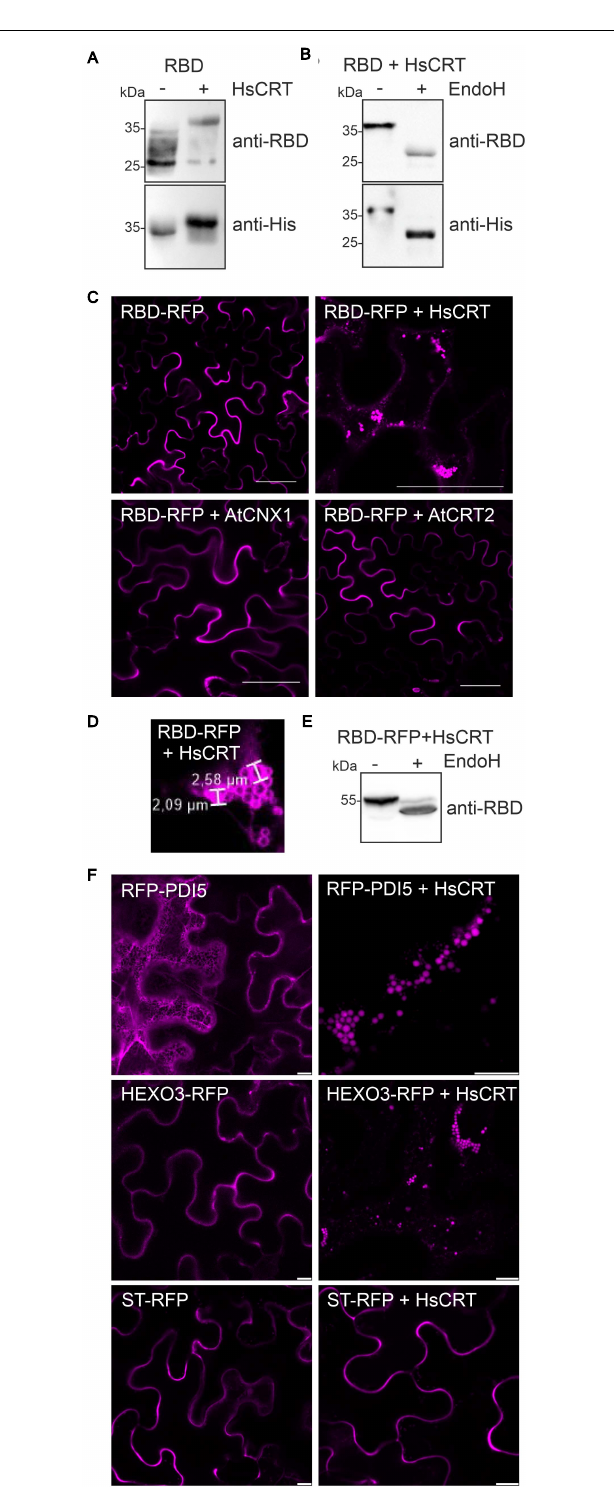
FIGURE 3 | Human CRT retains glycoproteins in intracellular compartments. (A) HsCRT was co-expressed with RBD and analyzed 4 days after infiltration of Nicotiana benthamiana WT by immunoblotting with antibodies against RBD or the 6x histidine tag. (B) Endo H digestion of RBD co-expressed